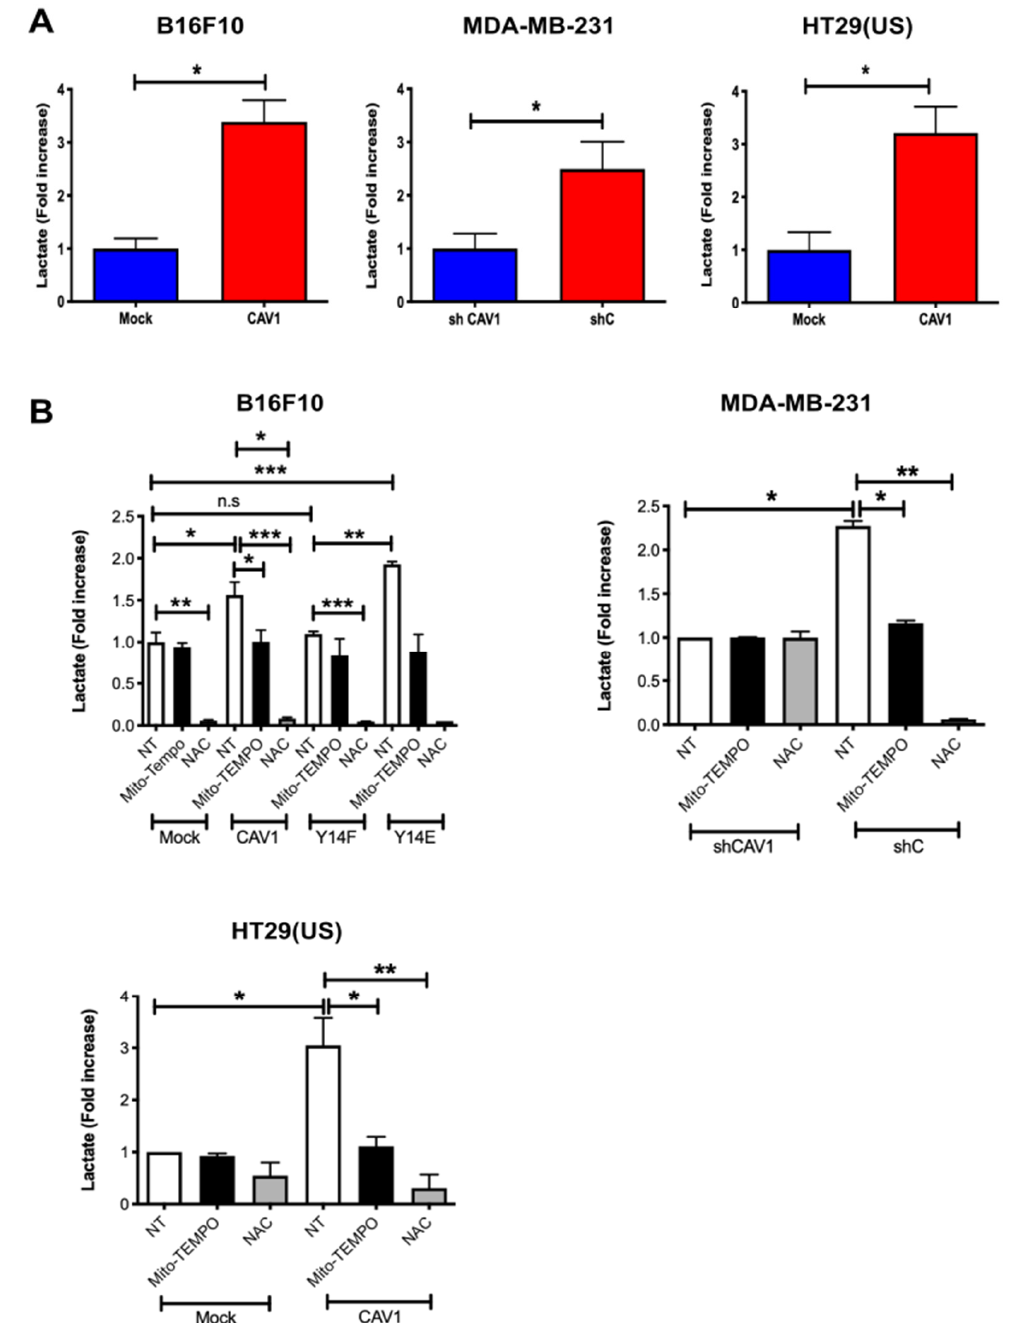
Figure 5. Caveolin-1-induced lactate release is inhibited by the treatment with antioxidants in metastatic cancer cells. ( A ) B16F10(Mock), B16F10(CAV1), MDA-MB-231(shCAV1), MDA-MB-231(shC), HT29(US)(Mock), or HT29(US)(CAV1) and ( B ) B16F10(Mock), B16F10(CAV1), B16F10(CAV1-Y14F), B16F10(CAV1-Y14E), MDA-MB-231(shCAV1), MDA-MB-231(shC), HT29(US)(Mock), or HT29(US)(CAV1) cells (6 × 10 5 ) were seeded in 6 cm dishes and 24 h later were treated for 24 h (HT29(US)) or 48 h (B16F10) with 1 mM IPTG. Then, cells were treated with 5 µ M Mito-TEMPO for 2 h or 4 mM N-acetylcysteine for 4 h, and media were then collected for lactate measurements at 490 nm. The graph shows the average of results from three independent experiments (mean ± SEM). The normalized value 1 is equivalent to 2 mM lactate. Significant differences are indicated, ns = non-significant, *** p < 0.001, ** p < 0.01, * p <